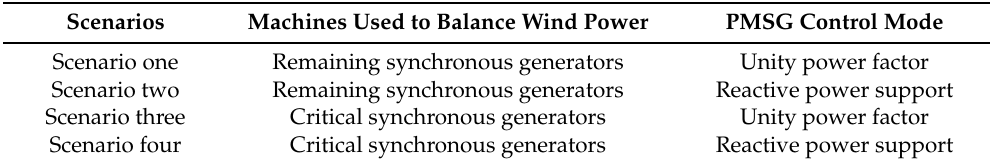
Table 1. Four operating scenarios of the wind case.